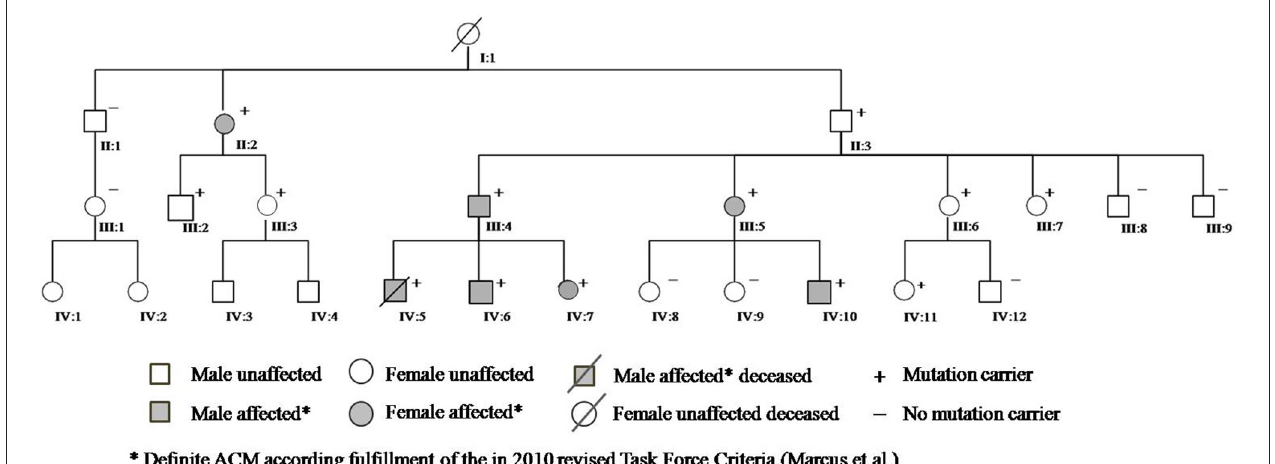
FIGURE 1 | Family